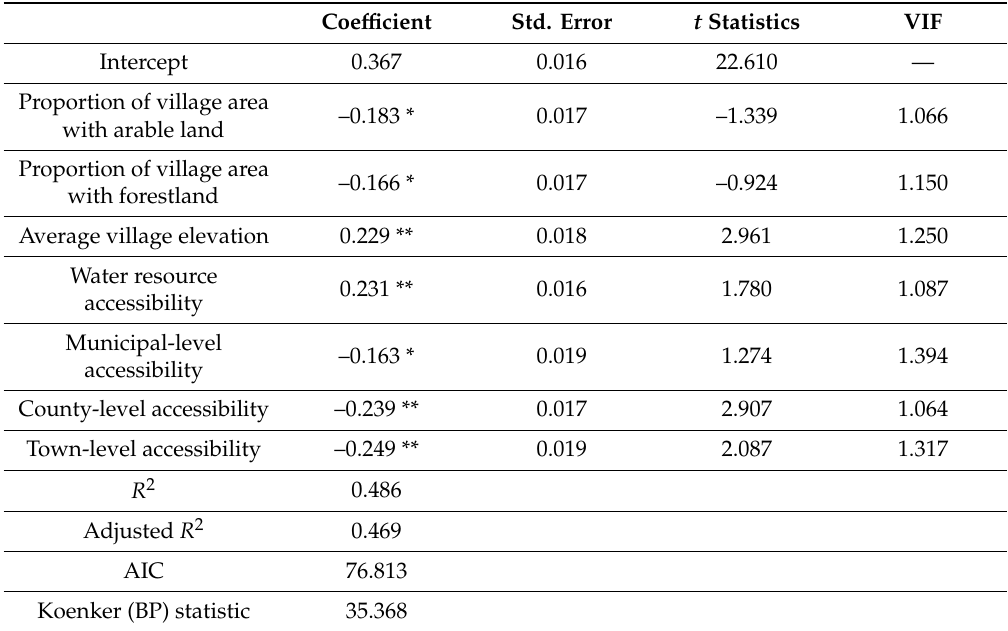
Table 2. Ordinary least squares (OLS) summary